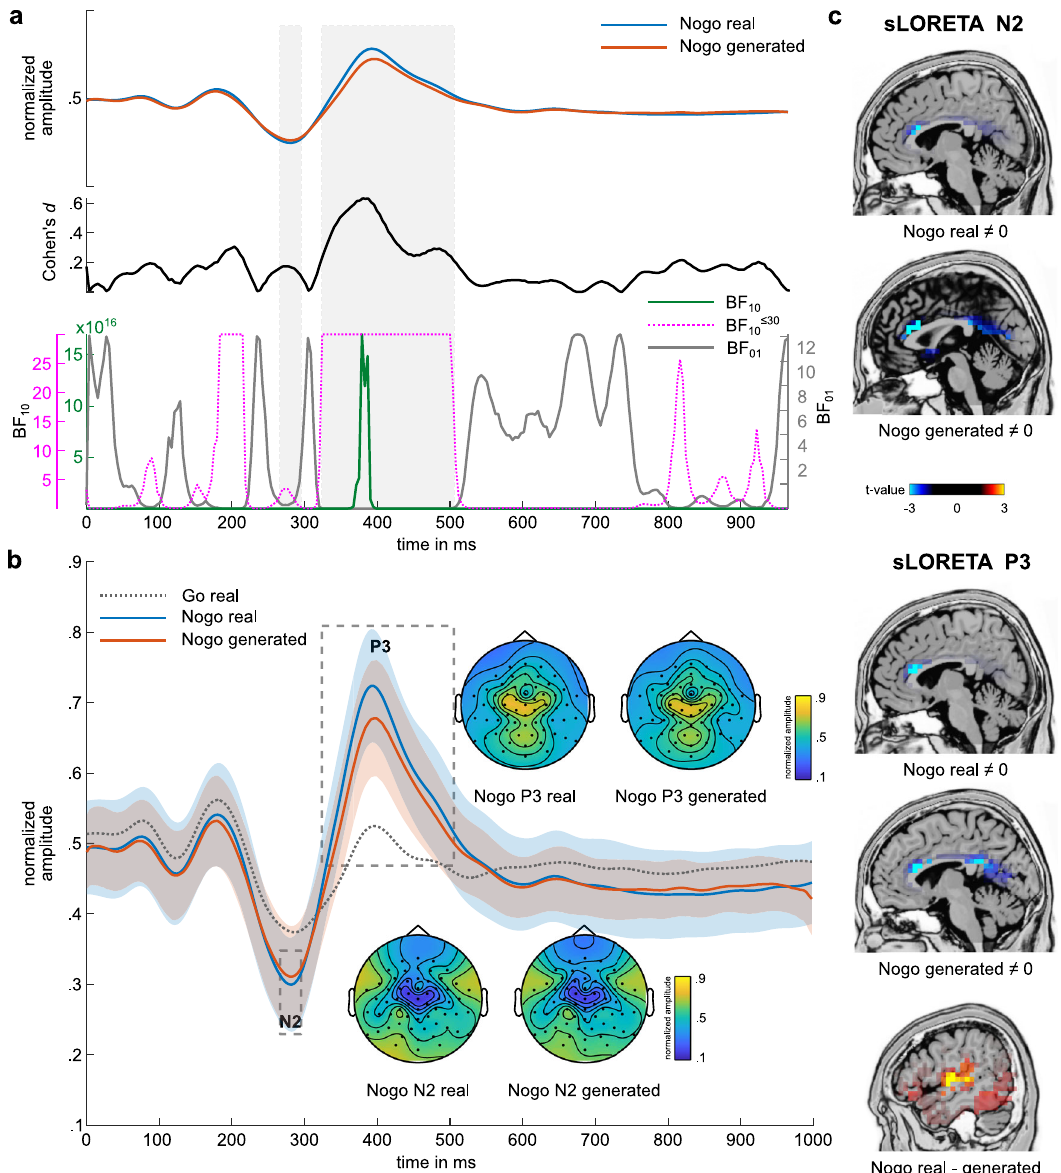
Fig. 3 The generated Nogo signal at pooled electrodes Cz, FCz, FC1, FC2, FC3, and FC4. a Pooled and EEG signal for real Nogo and generated Nogo signal (top). Cohen ’ s effect sizes are based on a t -test comparing each sample point between generated and real Nogo signal (middle). Bayes factor bf01 (gray) and bf10 (green) for each sample point compared between generated and real Nogo signal. The dotted purple line depicts bf10 with a cut-off value of 30 (i.e., values above 30 were set to 30). Gray boxes indicate the time window of the N2 and the P3. b Real (blue) and generated (orange) Nogo signal as well as real Go signal (dotted gray) at pooled electrodes Cz, FCz, FC1, FC2, FC3, and FC4. The blue and orange shadings indicate the standard deviation. Timepoint zero denotes the time point of stimulus onset. Gray boxes indicate time windows of N2 and P3 analysis. Topography plots showing the voltage distribution are given for real and generated Nogo signals in the N2 peak time windows and in the P3 time window. Colors denote amplitude differences. c Results of sLORETA analysis. In the N2 time window, comparing the Nogo real signal against zero, sLORETA revealed sources in BA24. Comparing the generated Nogo signal against 0, sources in BA24 were found. For the P3 time window, comparing the real Nogo signal against 0 showed sources in BA24. Comparing the generated Nogo signal against 0, sources in BA24 and BA31 were revealed. Contrasting real and generated Nogo signal, sLORETA revealed sources in BA13. The fi gures show normalized amplitudes. For the sLORETA, t -values are